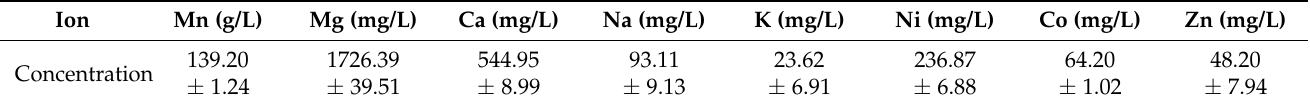
Table 1. The concentration of ions in the MnSO 4 leaching solution